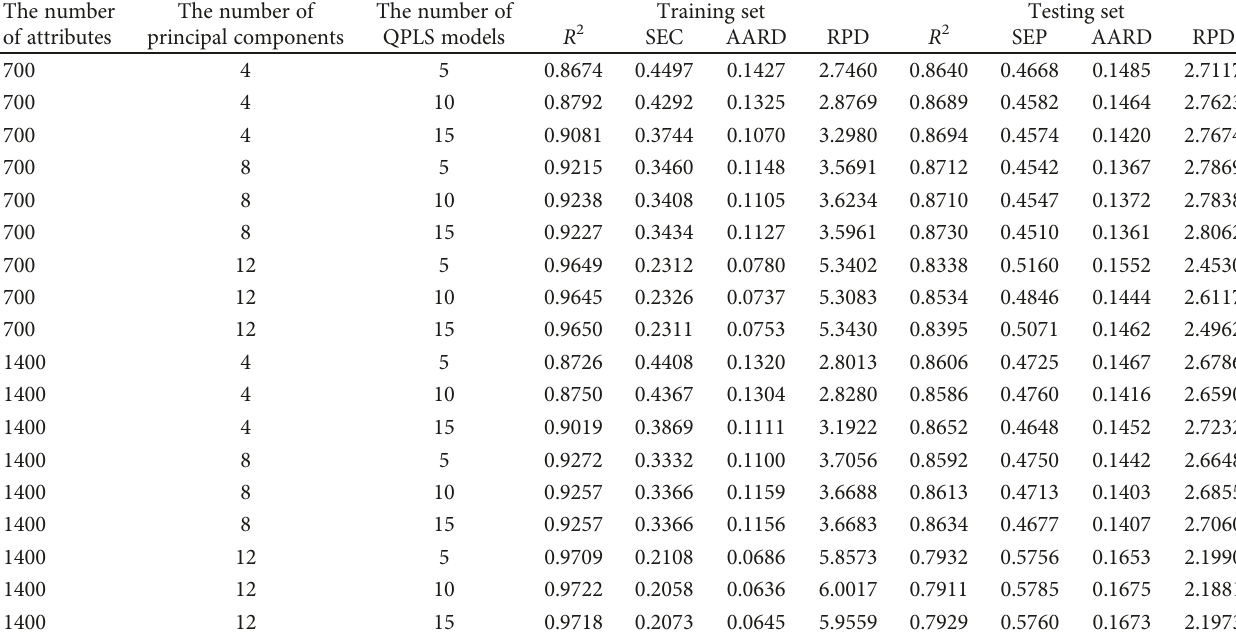
Table 3: The results of the k QPLS-SVR models for quanti fi cation of the relative content of Pst DNA in wheat leaves in the incubation period built when MSC was used as the preprocessing method of the original near-infrared